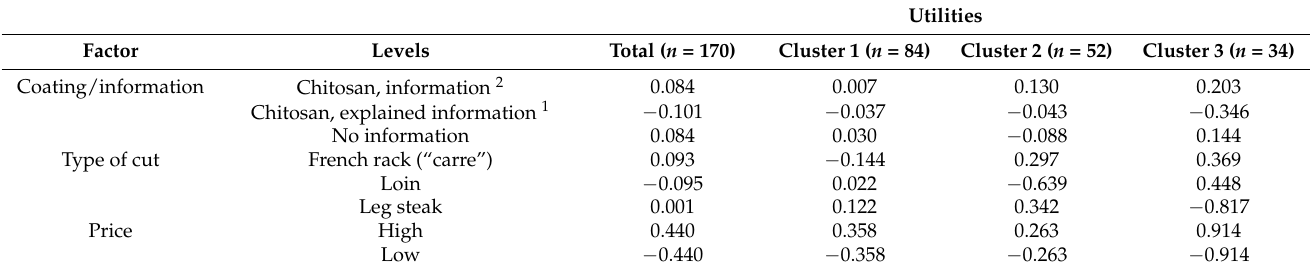
Table 3. Part-worth utilities of each investigated factor and levels for the intent to purchase of coated lamb